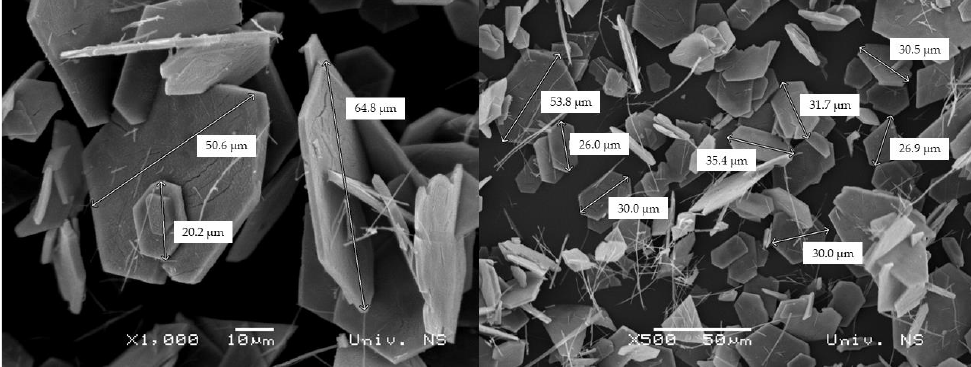
Figure 3. SEM micrographs of V 2 O 5 powder with different magnifications.